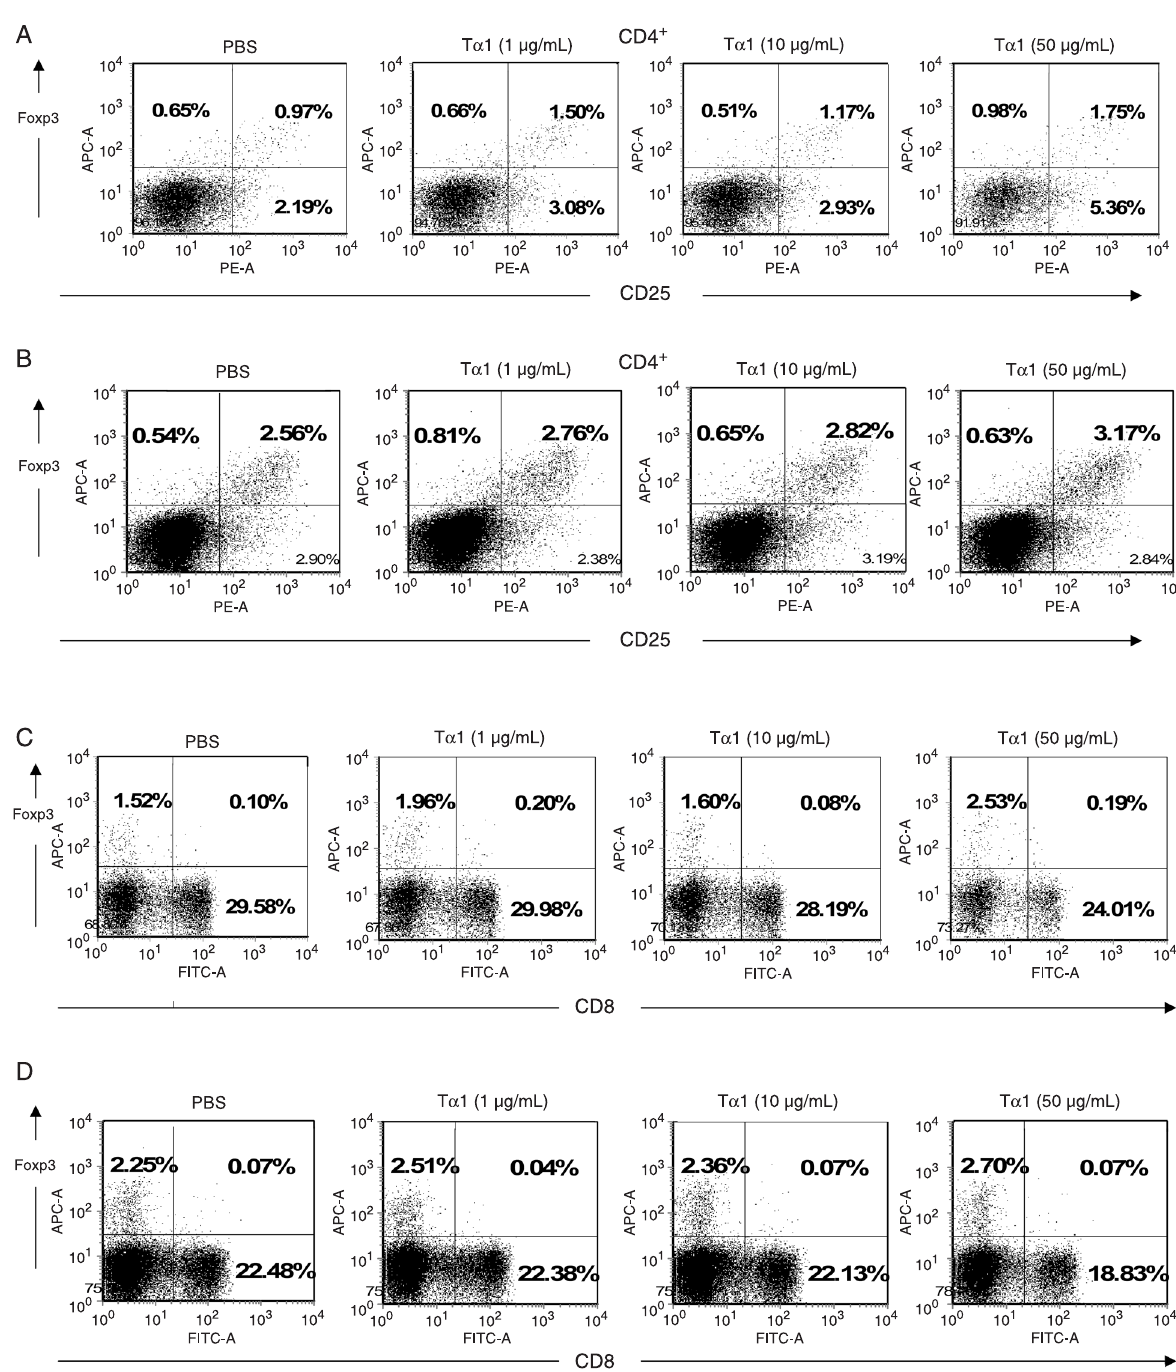
Figure 1. Frequency of CD4 + and CD8 + Tregs in PBMCs from healthy donors and gastric cancer patients upon treatment with PBS or with 1, 10, or 50 µg/mL Tα1. A , Analysis of the CD4 + CD25 + Foxp3 + subpopulation of PBMCs from healthy donors and B , gastric cancer patients. C , Analysis of the CD8 + and CD8 + Foxp3 + subpopulations of PBMCs from healthy donors and D , gastric cancer patients. Tregs = regulatory T cells; PBMCs = peripheral blood mononuclear